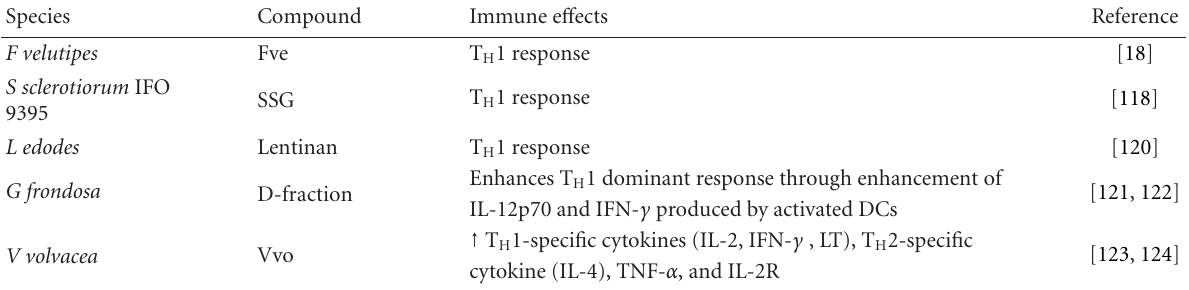
Table 6. Immunomodulatory activities of mushroom compounds on T